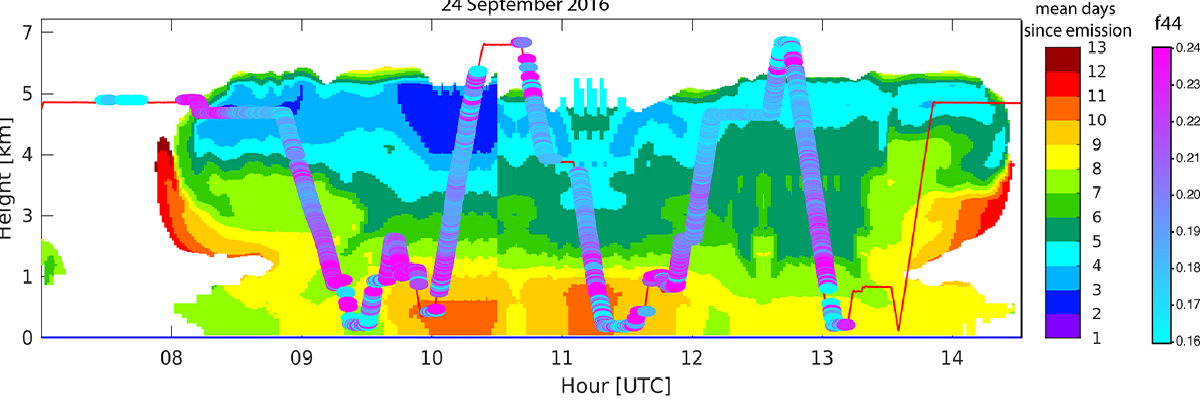
Figure 15. The WRF-AAM model-derived mean aerosol age along the P-3 flight track for 24 September 2016, overlain with a measure of aerosol oxidation derived from in situ f44 measurements on the P-3